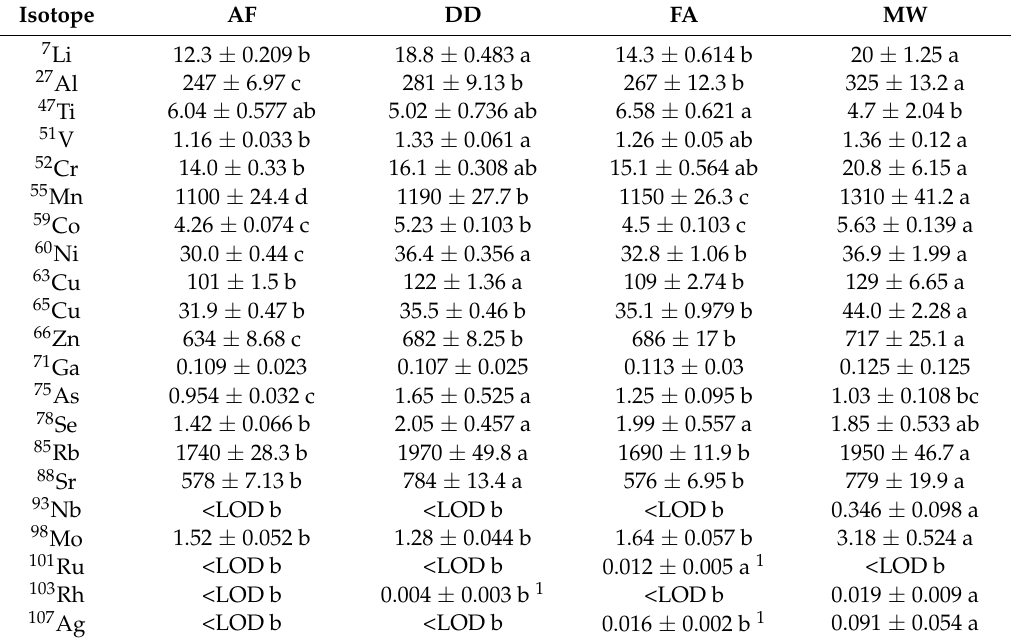
Table A1. Mean wine concentrations ( µ g/L) ± standard error of all analytes. Letters denote an analyte with a significant method effect by ANOVA ( p ≤ 0.05), means not sharing a letter for an isotope are significantly different by Tukey HSD’s (AF: Acidification prior to Filtration; DD: Direct Dilution; FA: Filtration prior to Acidification; MW: Microwave